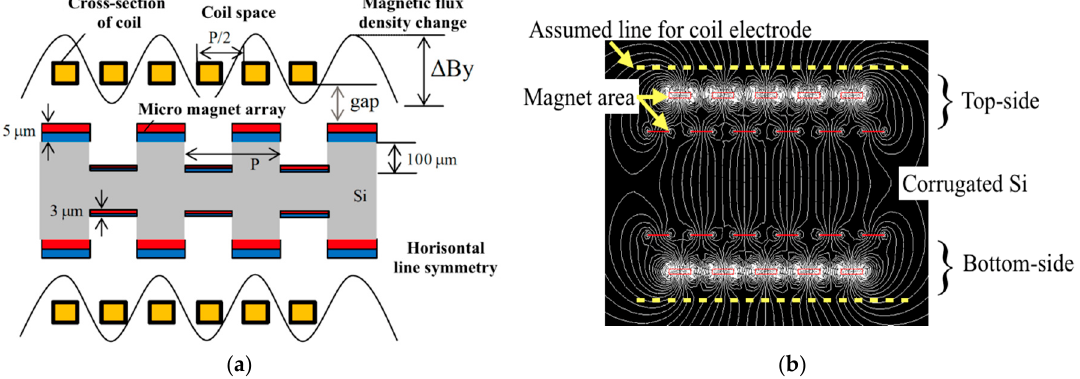
Figure 4. ( a ) Simplified model of double-sided EMG VEH for analysis; ( b ) Electromagnetic field simulation result from FEM (ANSYS, Canonsburg, PA,